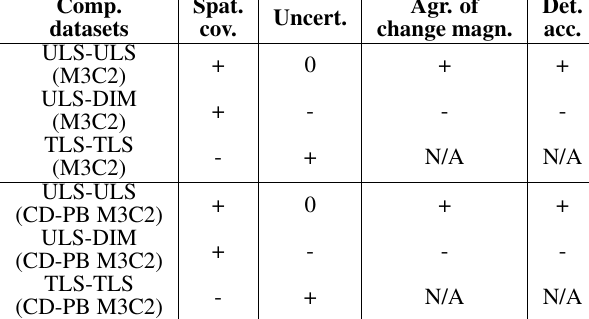
derived from airborne laser scanning data. Comp. Spat. Agr. of Det. Uncert. datasets cov. change magn. acc.